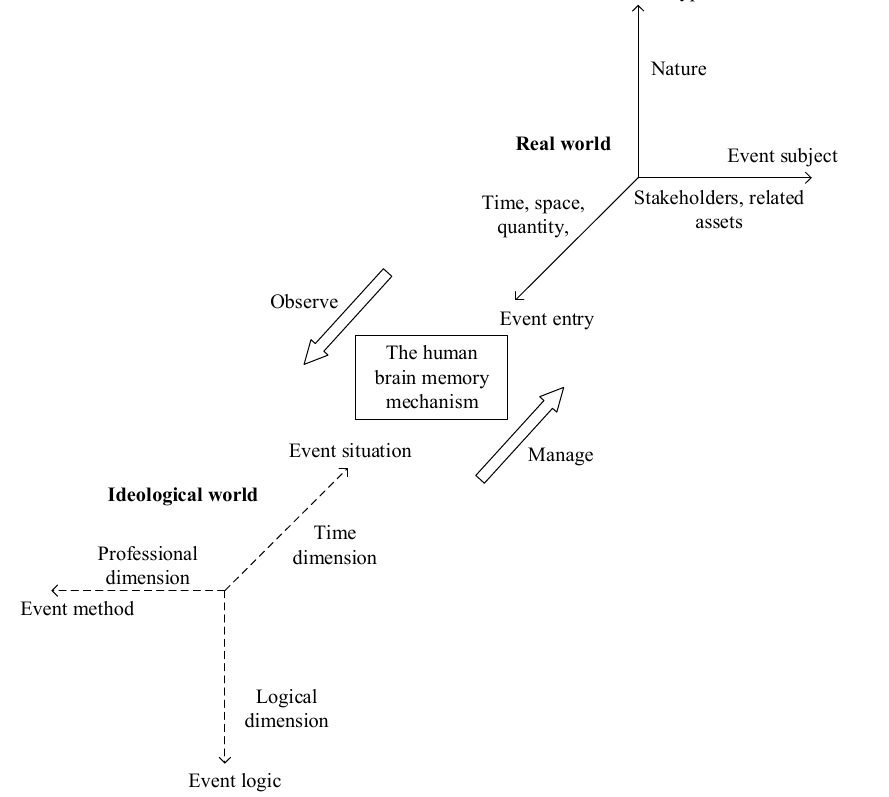
Figure 4. Explosion structure of event meta based on the human brain memory